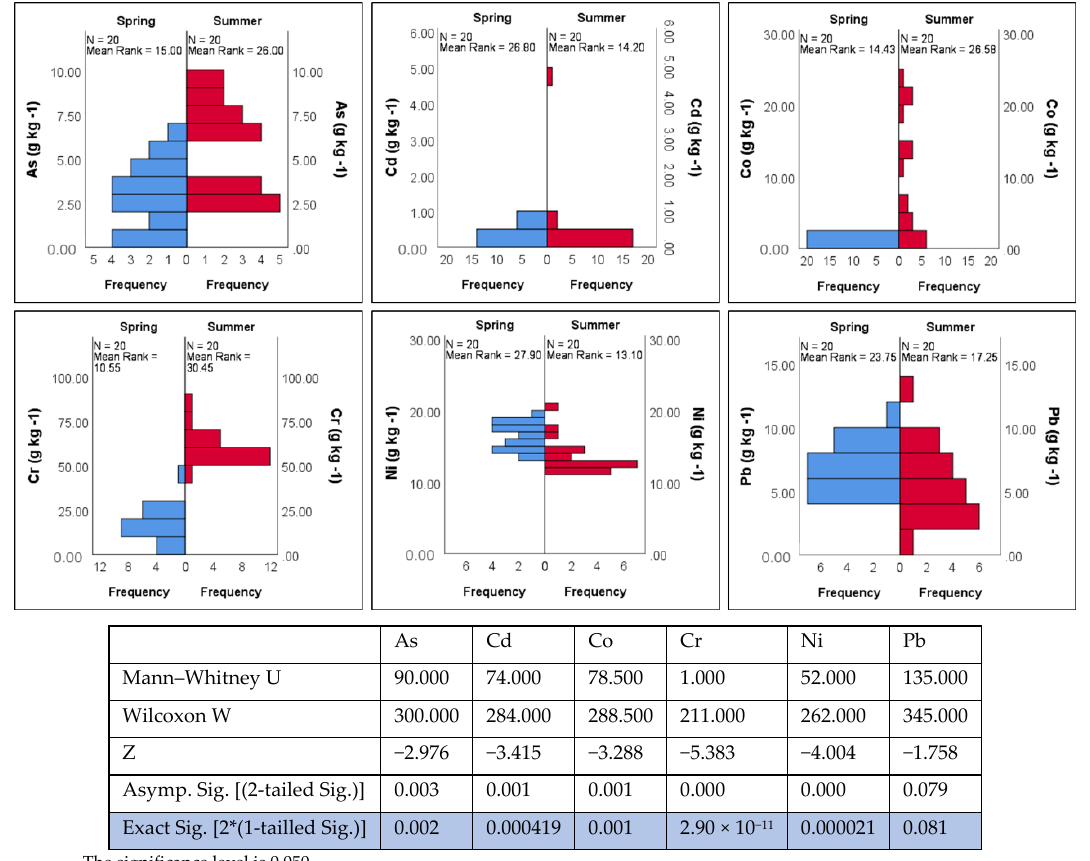
Figure 3. Histograms of the heavy metal concentrations and statistical results of the Mann–Whit- ney U test for examining the difference of the concentrations between spring and summer sam- ples.